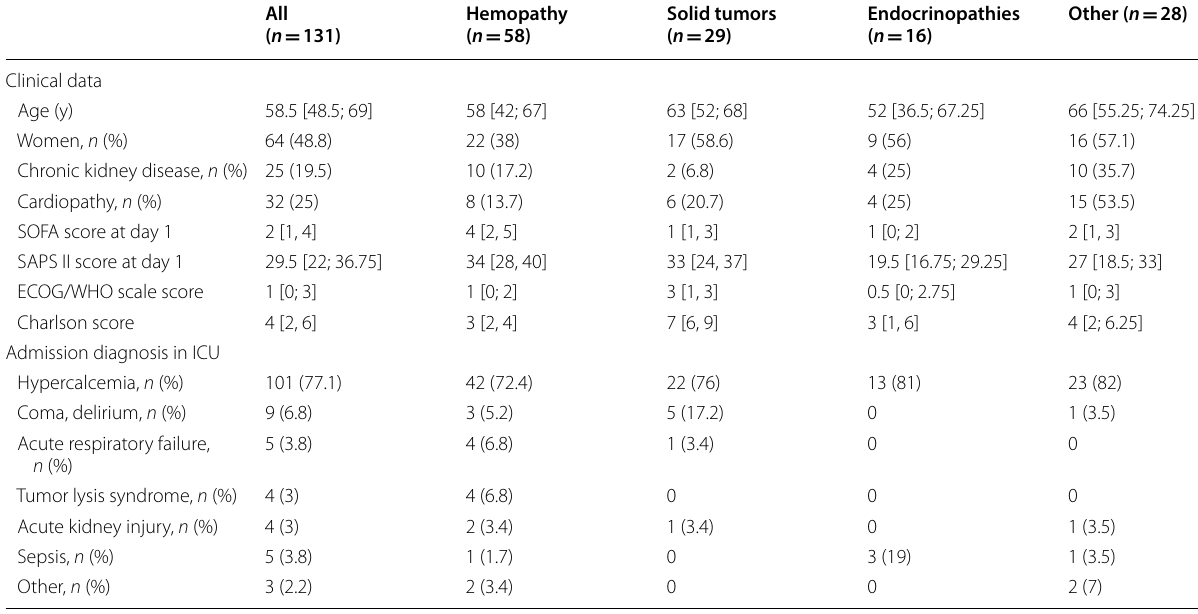
Values for categorical variables are given as number (percentage); values for continuous variables, as median [interquartile range] Other causes included iatrogenic causes ( n 16; 57.1%), sarcoidosis ( n 4; 14.2%), tuberculosis ( n 1; 3.5%), atypical mycobacterial infection ( n = = = dehydration ( n 1; 3.5%), and unknown causes ( n 5; 17.8%) = = ECOG/WHO Eastern Cooperative Oncology Group/World Health Organization, SAPS II Simplified Acute Physiology Score, SOFA Sequential Organ Failure